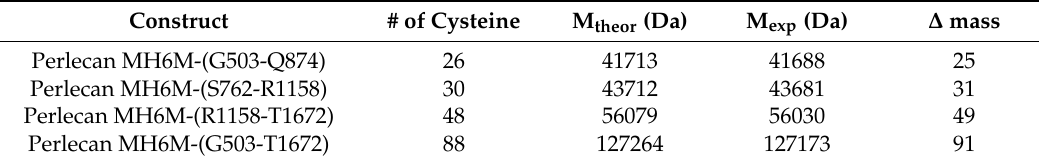
Table 1. Molecular weight analysis by electrospray ionization mass spectrometry (ESI-MS) for purified proteins. The theoretical average molecular weight (M theor ) of the His-tag perlecan constructs in